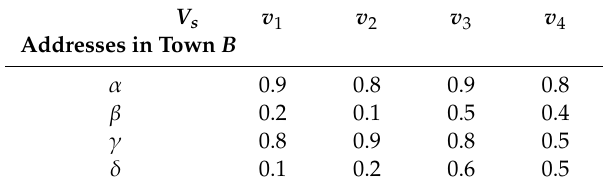
Table 5. Attribute value appurtenance fuzzy degree function for s ∈ A on Town B ( h s